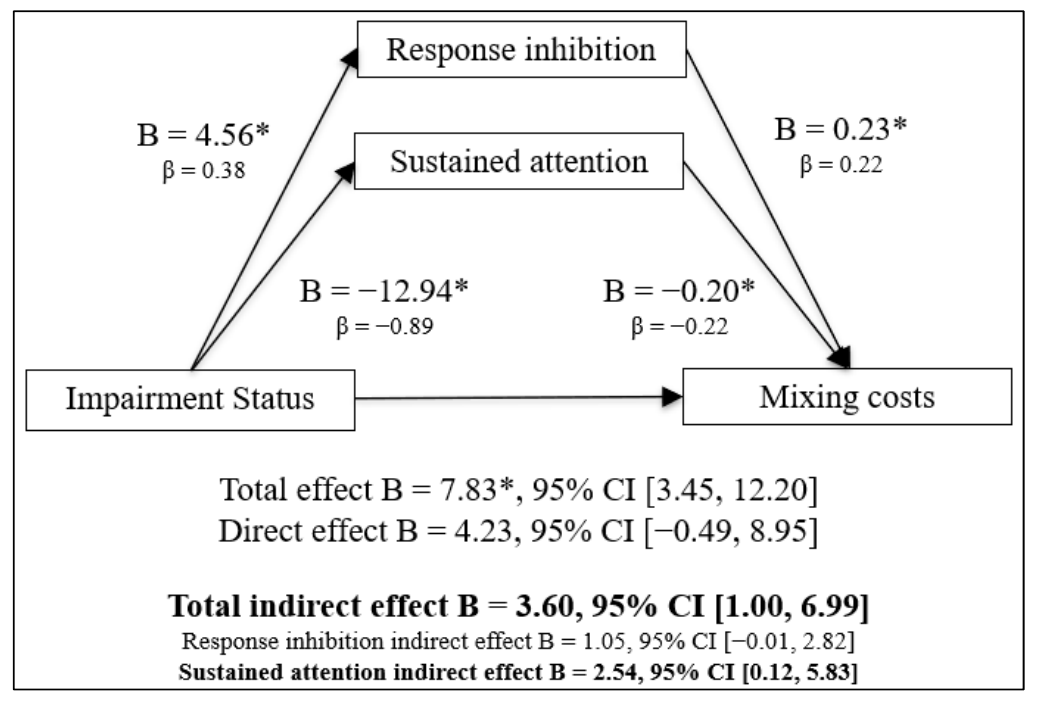
Figure 2. Mediation model. CI: Confidence Interval; *: p < 0.05; meaningful mediation effects are in boldface. The total effect is the effect of Impairment Status (X) on Mixing costs (Y), excluding Response inhibition/Sustained attention (M). The direct effect is the effect of Impairment Status (X) on Mixing costs (Y), controlling for Response inhibition/Sustained attention (M). The indirect effect is the effect of Impairment Status (X) on Mixing costs (Y) through Response inhibition/Sustained attention (M).